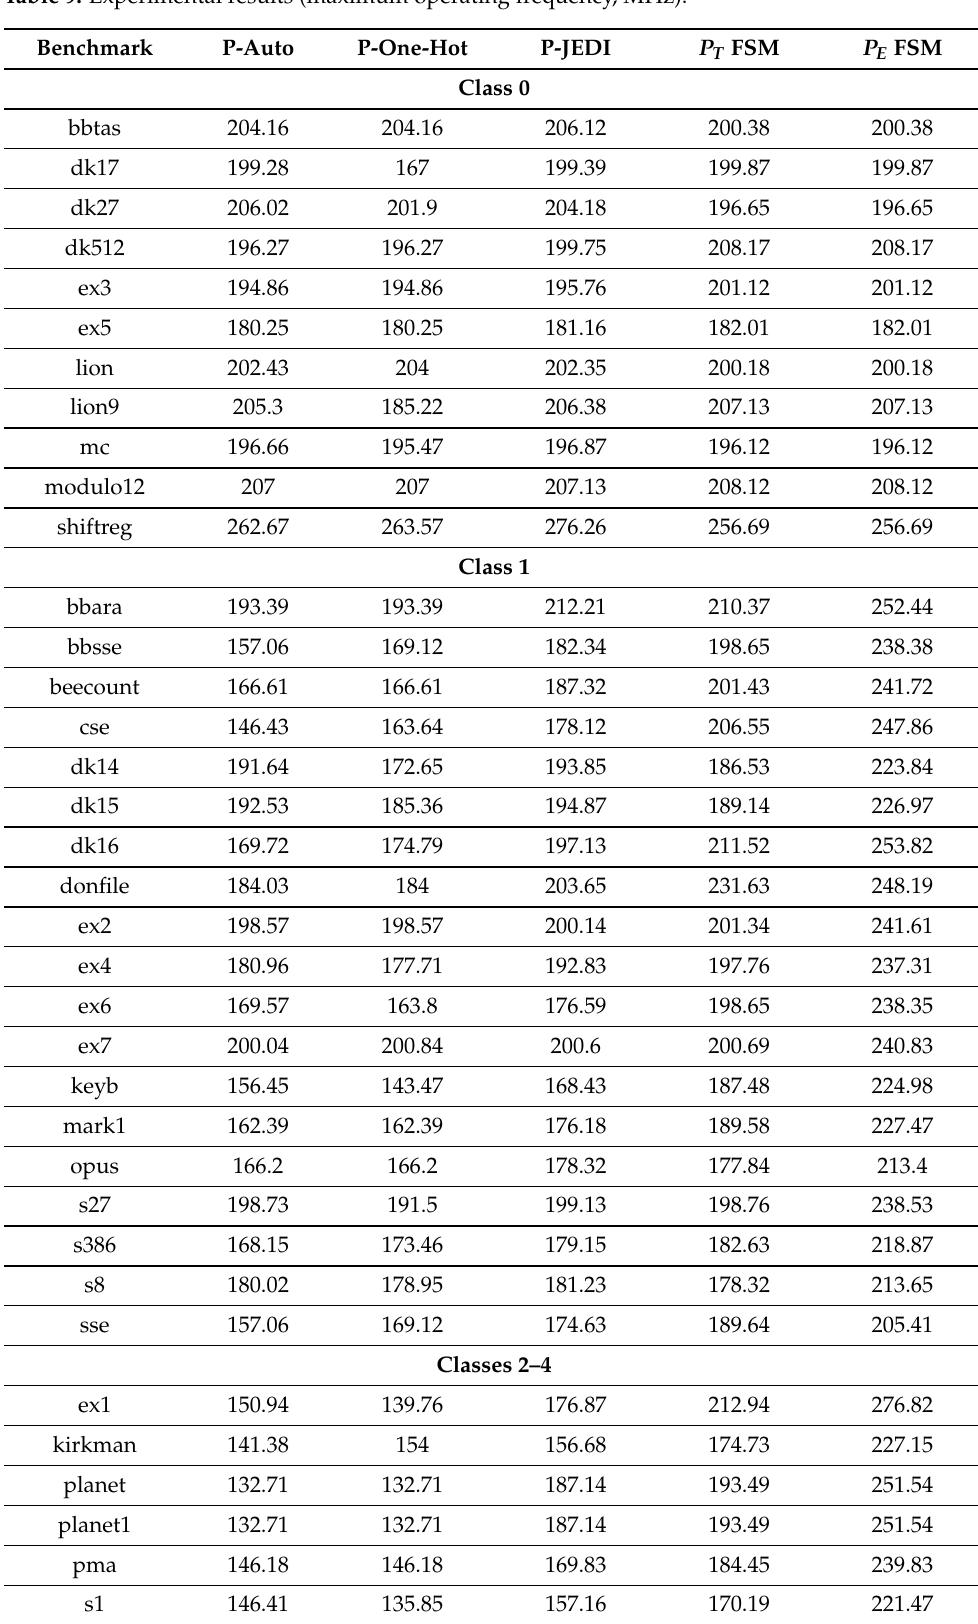
Table 9. Experimental results (maximum operating frequency,